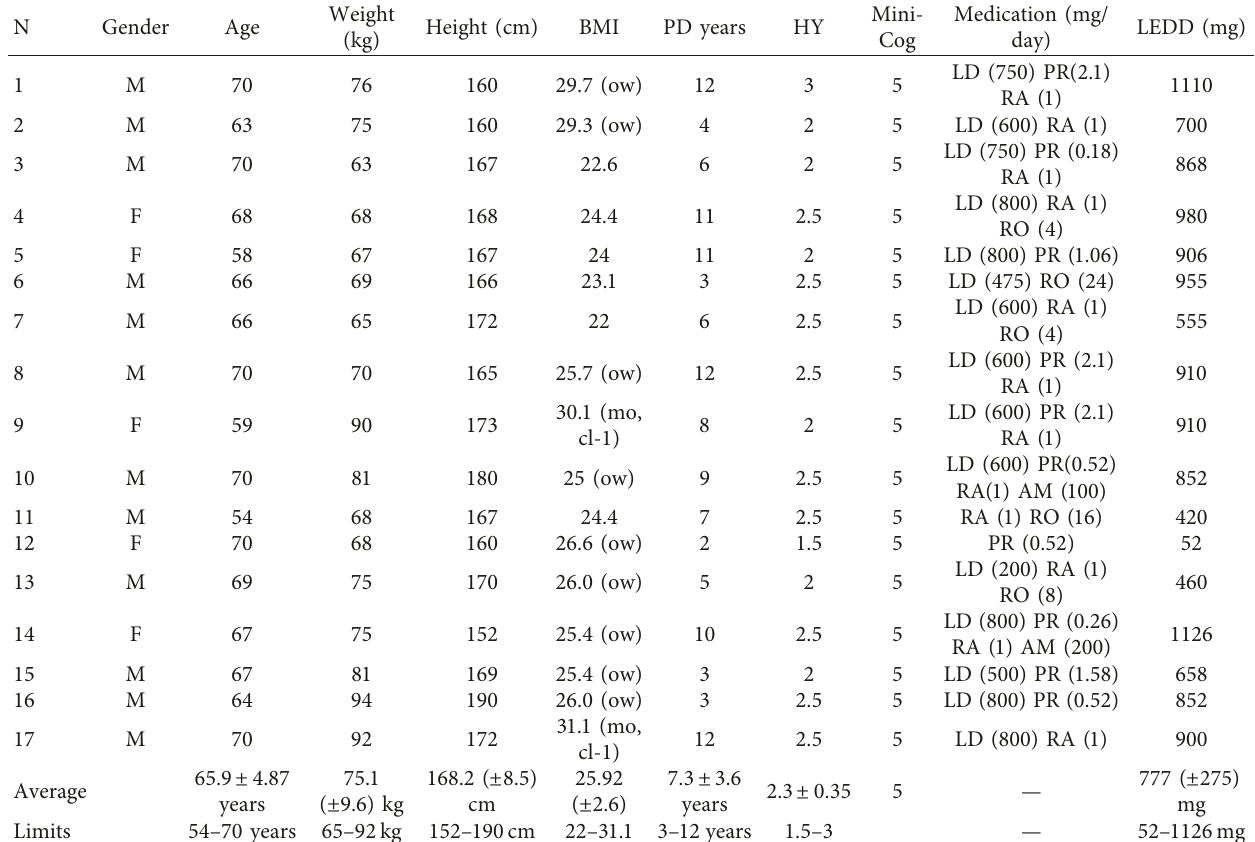
Table 2: Clinical characteristics and profile of administered anti-Parkinsonian